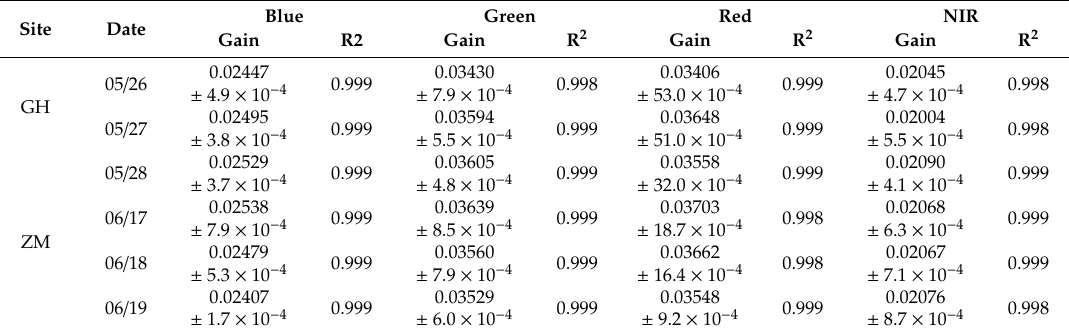
Table 4. Daily absolute calibration results calculated using linear regression between the digital number (DN) and the top of atmosphere (TOA) radiance (GH: Goheung, ZM: Zuunmod). Site